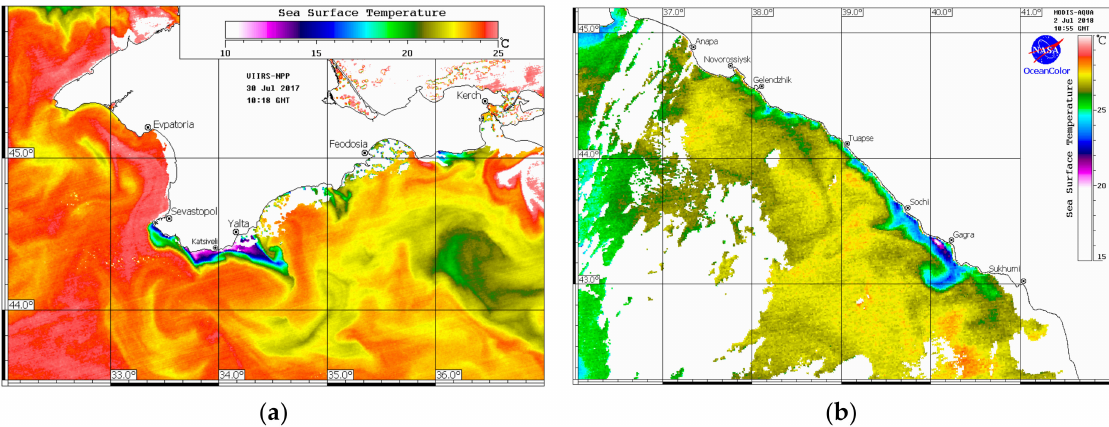
Figure 16. ( a ) Coastal upwelling (shown in SST) at the southern coast of the Crimea on 30 July 2017 (VIIRS-NPP, 10:18 GMT); ( b ) coastal upwelling (shown in SST) along the coast of the Krasnodar Krai on 2 July 2018 (MODIS-Aqua, 10:55 GMT) (courtesy by D.M. Soloviev, Marine Hydrophysical